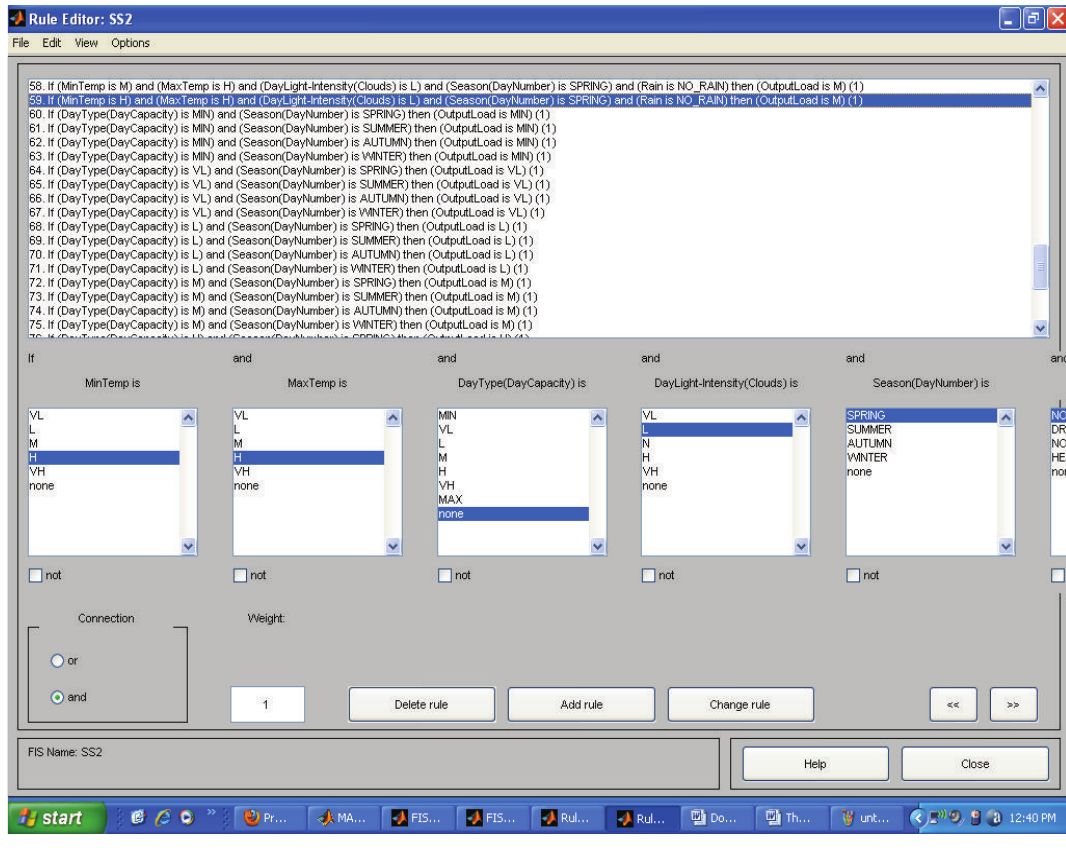
Figure 3: Rules of fuzzy